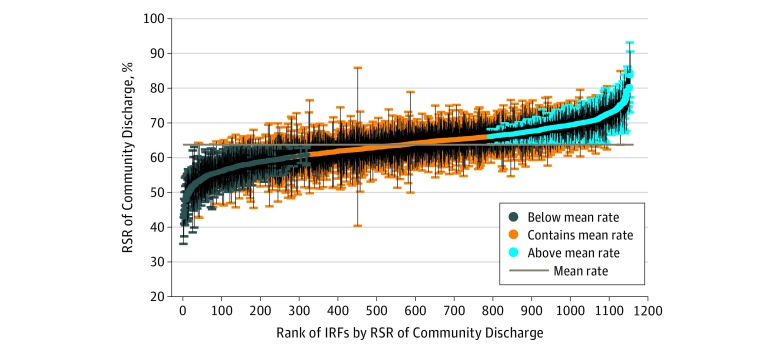
Risk-Standardized Rates (RSRs) of Successful Community Discharge After Inpatient RehabilitationRates are shown for the 1154 inpatient rehabilitation facilities submitting claims to the Centers for Medicare & Medicaid Services during the study period. Facilities are shown in rank order, with a dot representing their RSR of community discharge and a corresponding vertical line representing the 95% CI for the rate. Two hundred sixteen inpatient rehabilitation facilities (18.7%) had 95% CIs entirely above the overall mean rate; 419 facilities (63.7%), 95% CIs that contain the mean rate; and 203 facilities (17.6%), 95% CIs entirely below the mean rate. IRF indicates inpatient rehabilitation facility.